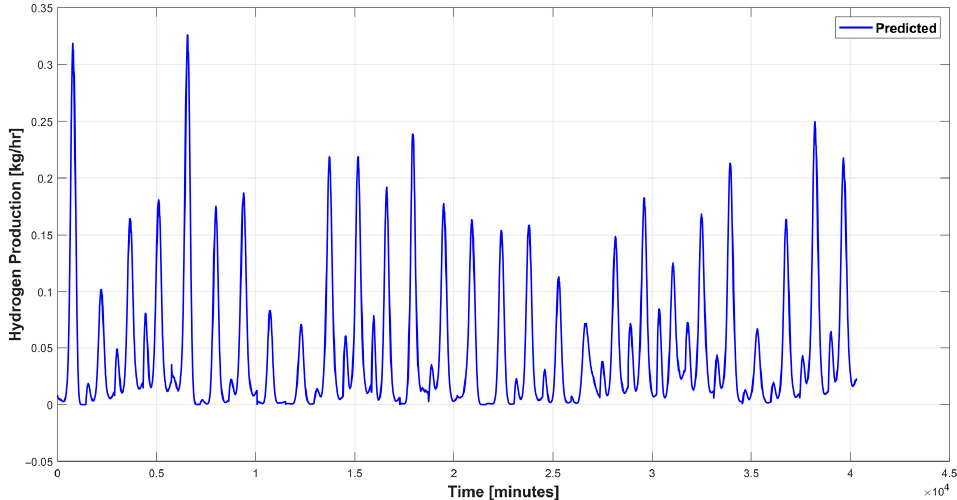
Figure 10. Estimated rate of hydrogen production.